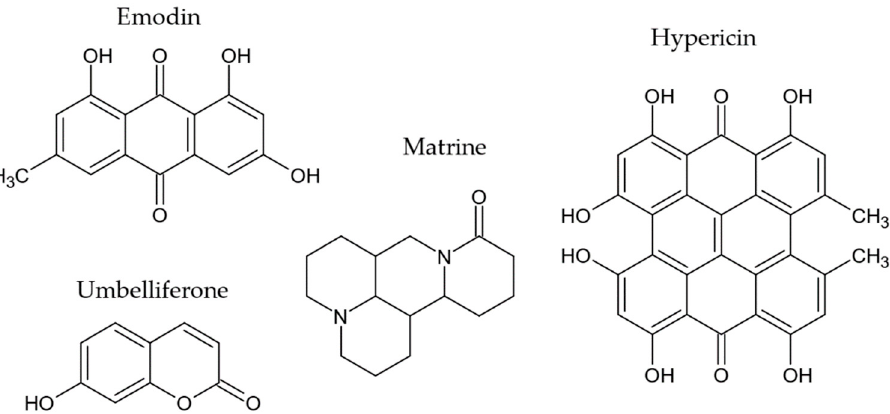
Figure 8. Other antiAGEs compounds reported in endophytes.